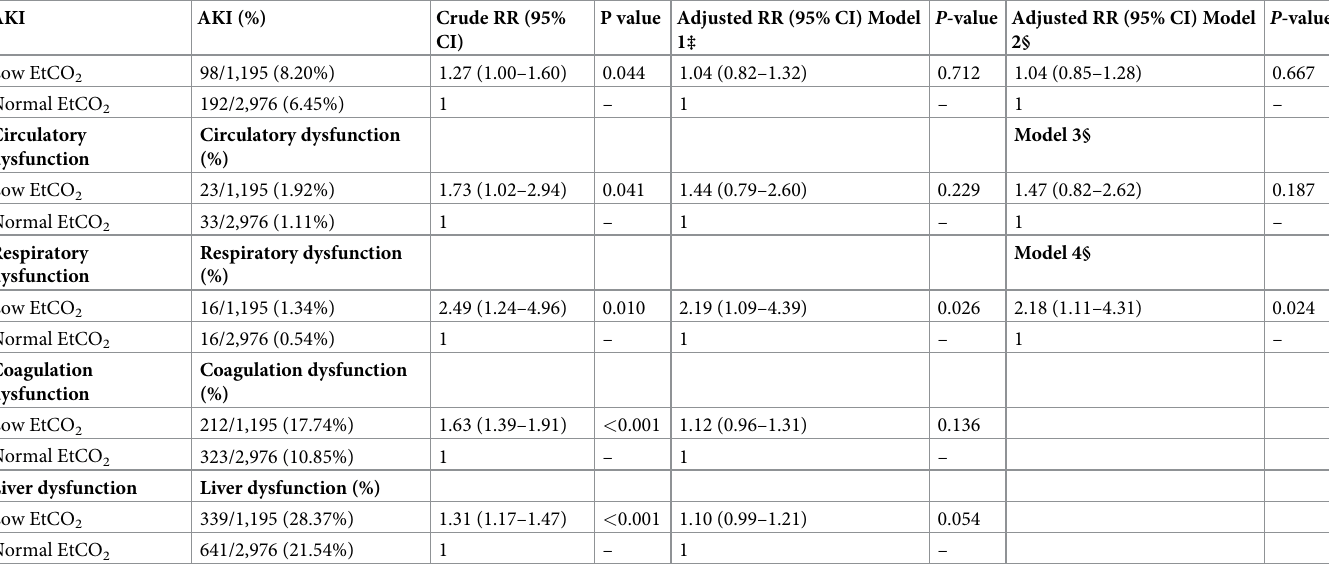
Table 3. Multivariable analysis of the relationship between EtCO 2 and secondary